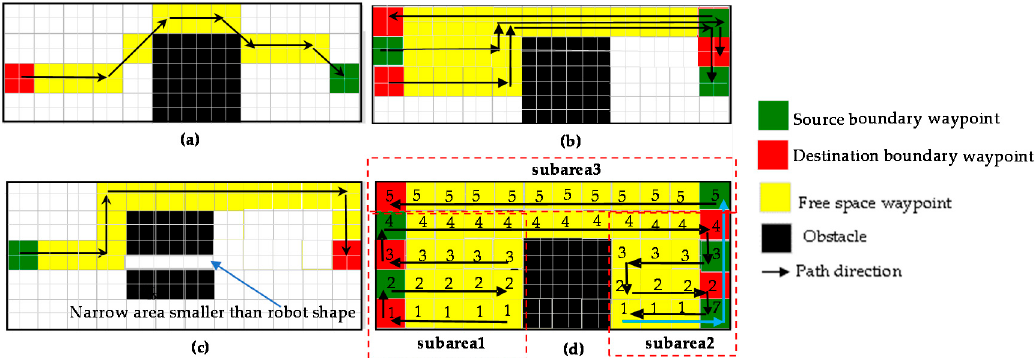
Figure 8. Drawbacks of conventional A-star based methods for area coverage. ( a ) A-star with the diagonal movement, ( b ) A-star for area coverage, ( c ) uncovered narrow space by fix morphology, ( d ) subareas A-star based area coverage [8].